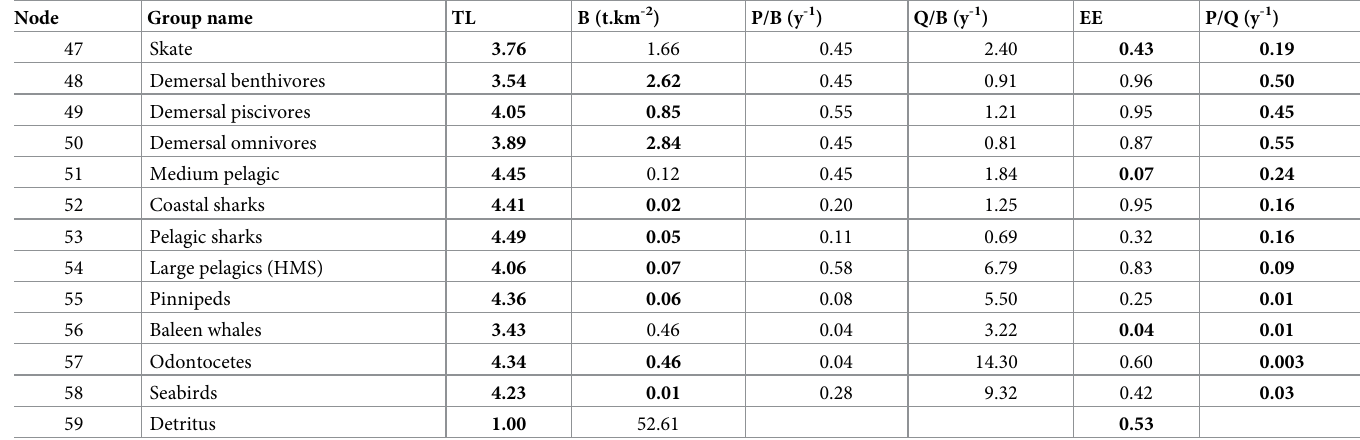
to be estimated by RAB model (Table 2), resulting in 3,603,452 metric tons increase in total biomass over the CAB model, excluding the alosine biomass input. Impacted species were grouped in broader categories as follow: forage species, piscivorous fish, invertebrates and ver- tebrates (sharks and other species of conservation concern). Besides the anadromous alosine group, the forage species category included mesopelagics (e.g. Maurolicus sp.), Atlantic her- ring, the three size classes of Atlantic menhaden ( Brevoortia tyrannus ), anchovies (e.g. Ancho sp.), Atlantic mackerel ( Scomber scombrus ), butterfish ( Peprilus triacanthus ), and other small pelagics (e.g. Ammodytes sp.). Butterfish was the only forage species in RAB which the biomass was not calculated by the RAB model (Table 2). For the entire forage species, there was total biomass increase of 1,957,052 metric tons or 50.7%.For both models the forage species groups with the greatest niche overlap where anadromous alosine, other small pelagics, and the three menhaden age classes (Fig 4). There was a considerable shift towards a higher predator overlap index in the RAB model, which was observed among a number of species with the anadro- mous alosine group (Fig 4). The RAB model indicates stronger predator overlap between anadromous alosines and Atlantic herring, medium and large menhaden, and mesopelagics, demonstrating the potential food base for the main apex predators.